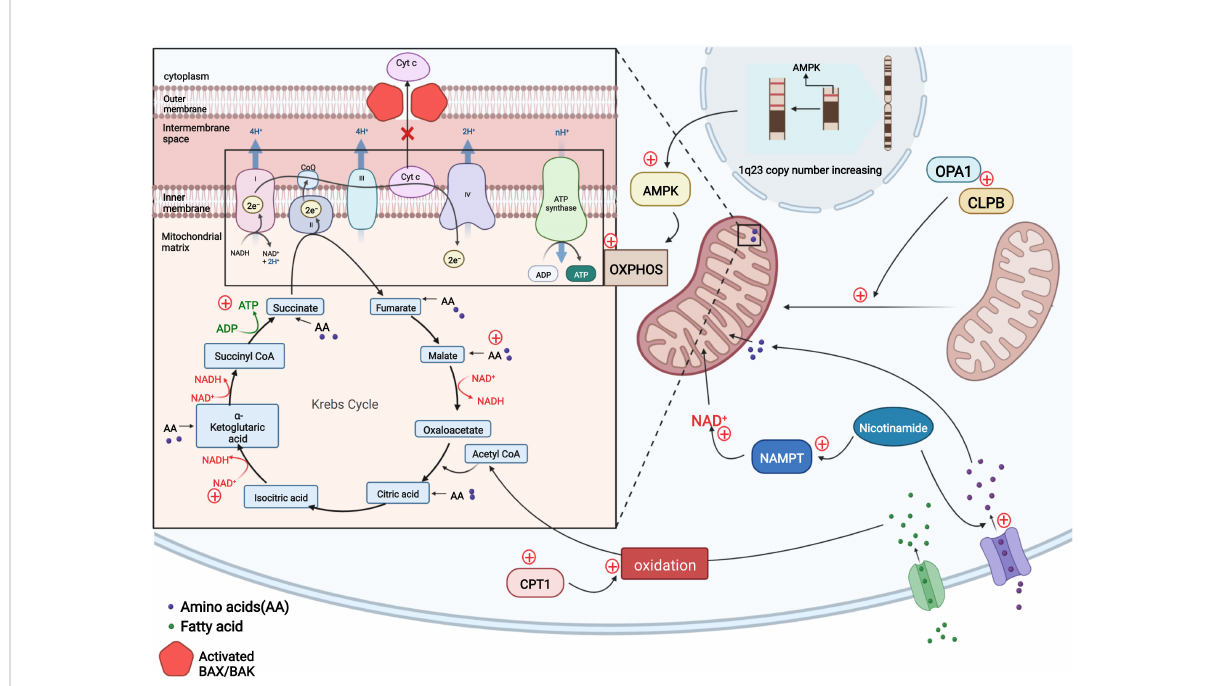
FIGURE 2 In resistant LSCs, copy number upregulation occurred in the 1q23 chromosome region, leading to the upregulation of AMPK-related proteins and a subsequent increase in the level of OXPHOS to compensate for the impaired energy production induced by venetoclax-mediated cytochrome c release and decreased apoptosis. Nicotinamide activates the TCA cycle and increases ATP levels in two ways by generating NAD+ via NAMPT and increasing the levels of TCA intermediates by activating amino acid metabolism. Intracellular CPT1 protein expression is upregulated, and CPT1 promotes fatty acid oxidation to allow fatty acids to enter the TCA cycle and maintain cellular energy. The OPA1 protein and CLPB protein may be upregulated in AML cells to maintain the mitochondrial cristae structure, including increasing the number of mitochondrial cristae and narrowing the cristae lumen to ensure normal mitochondrial function and the inhibition of cytochrome c release. (Adapted from "Electron Transport Chain", by BioRender.com (2020). Retrieved from